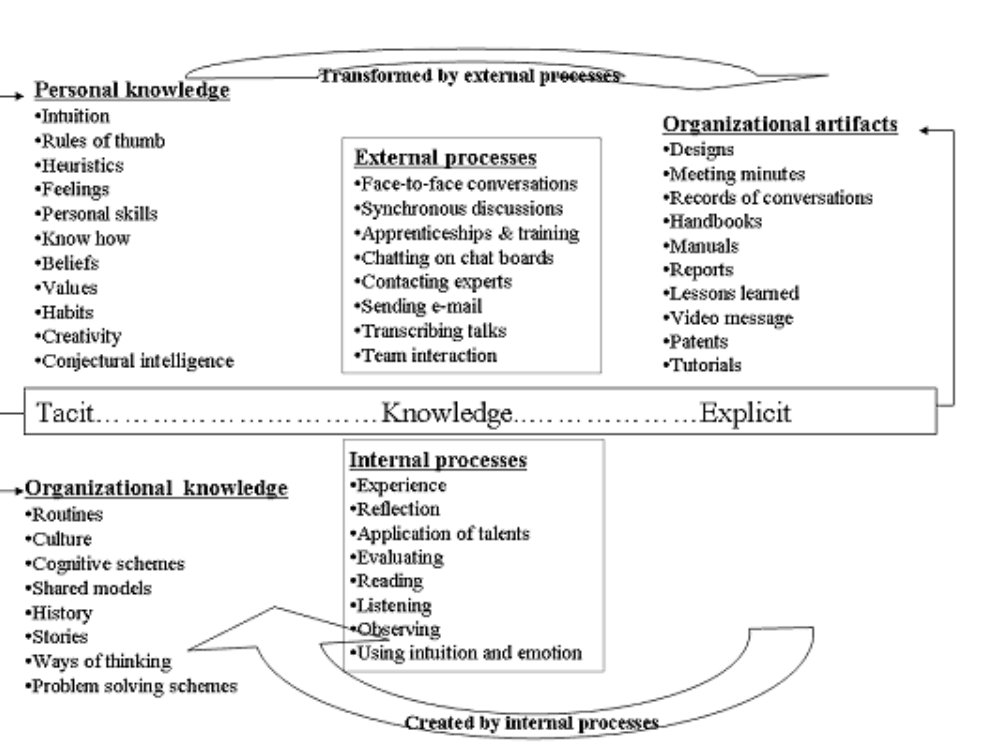
Figure 2 Tacit-explicit knowledge